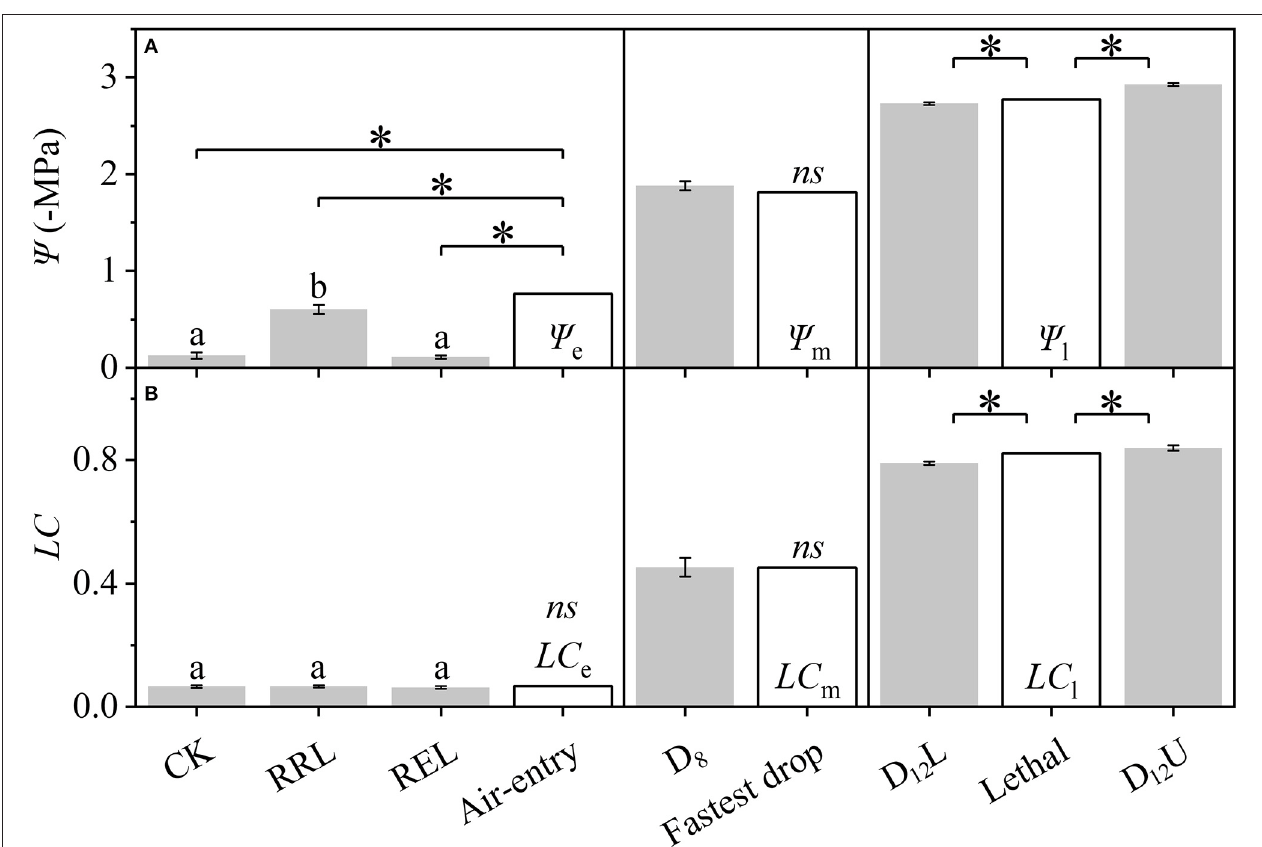
FIGURE 3 | Differences among the CK, RRL, REL, and Ψ e , between D 8 and Ψ m , and among D 12 L, Ψ l , and D 12 U for the stem water potential ( Ψ , A ) and loss of conductivity ( LC , B ). CK, control group; D 8 , moderate drought group; D 12 U, upper part of the severe drought group; D 12 L, lower part of the severe drought group; RRL, lower part of the group in which rewatering occurred until rebudding was present; REL, lower part of the group in which rewatering occurred until the end of the experiment. The data that belongs to CK, RRL, REL, D 8 , D 12 L, and D 12 U are represented by the mean ± 1 SE and n = 10. Data of the three key points are signified by the calculated results via the DM. One-way ANOVA and Duncan multiple comparisons were performed to detect the differences among CK, RRL, and REL; different letters indicate significant differences where P < 0.05. The one-sample t -test was used to detect the difference between the calculated and experimental results; ns indicates no significant difference; the symbol * P <